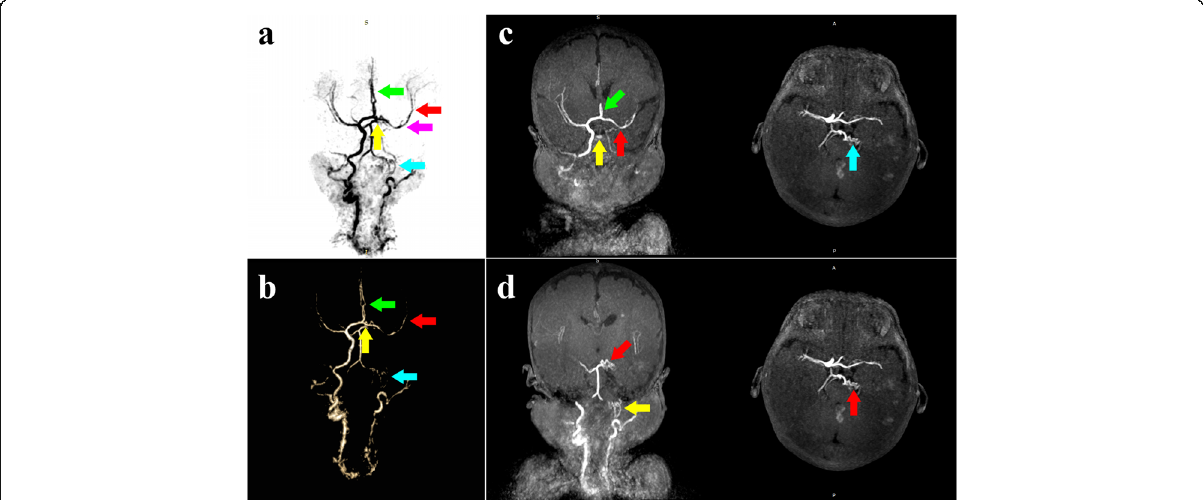
Fig. 2 MRA imaging. a Red arrow shows the left middle cerebral artery, green arrow shows the left anterior cerebral artery, purple arrow shows absence of the left internal carotid artery, yellow arrow shows anterior communicating artery feeding the left middle cerebral artery and anterior cerebral artery, and blue arrow shows vascular tuft being fed from the left vertebral artery. b Red arrow shows the left middle cerebral artery, green arrow shows the left anterior cerebral artery, yellow arrow shows anterior communicating artery feeding he left middle cerebral artery and anterior cerebral artery, and blue arrow shows vascular tuft being fed from the left vertebral artery. c Red arrow shows absent left internal carotid artery, green arrow shows the left anterior cerebral artery, yellow arrow shows vascular malformation in the region of quadrigeminal cistern, and blue arrows show vascular tuft being fed from the left vertebral artery. d Red arrows show tuft of serpiginous vessels in the left anterior ambient cistern, and yellow arrow shows vascular nidus in the quadrigeminal